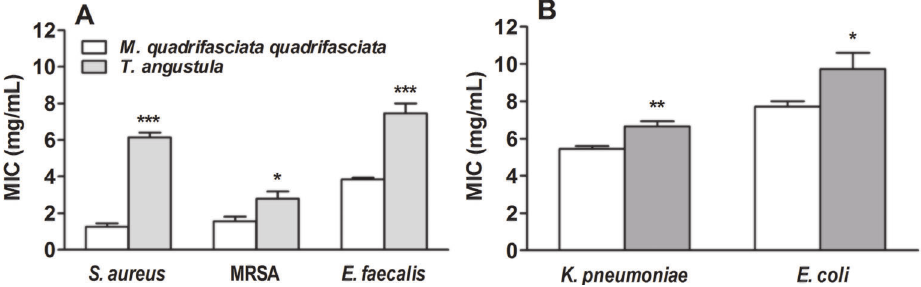
Figure 3. Susceptibility of bacterial strains to ethanolic extracts of propolis in minimal inhibitory concentration (MIC). A , Gram-positive bacteria: S. aureus (ATCC 25923), methicillin-resistant S. aureus (MRSA, clinical isolate), and E. faecalis (ATCC 29212); B , Gram- negative bacteria: K. pneumoniae (ATCC 23883) and E. coli (ATCC 25922). Data are reported as means ± SE of 3 – 5 independent experiments performed in triplicate. *P o 0.05, **P o 0.01 and ***P o 0.001 compared to M. quadrifasciata quadrifasciata (ANOVA followed by Bonferroni ’ s